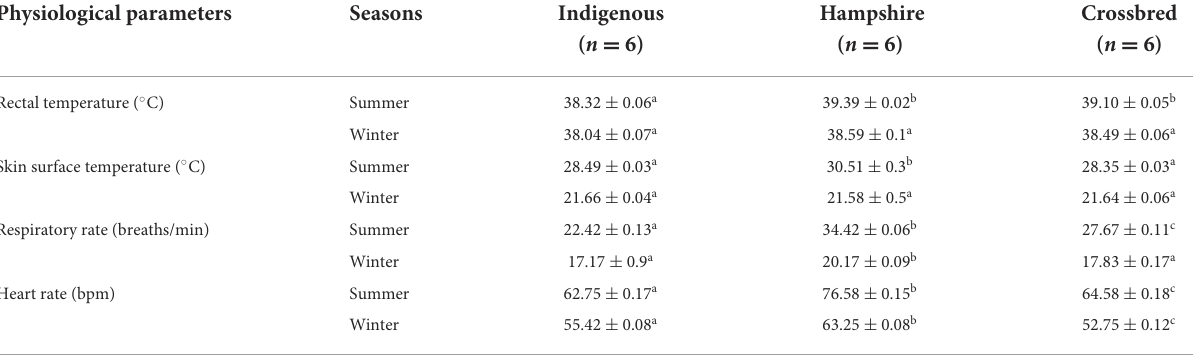
TABLE 2 Means ± SE for physiological parameters of indigenous, Hampshire, and crossbred pigs during the study period. Physiological